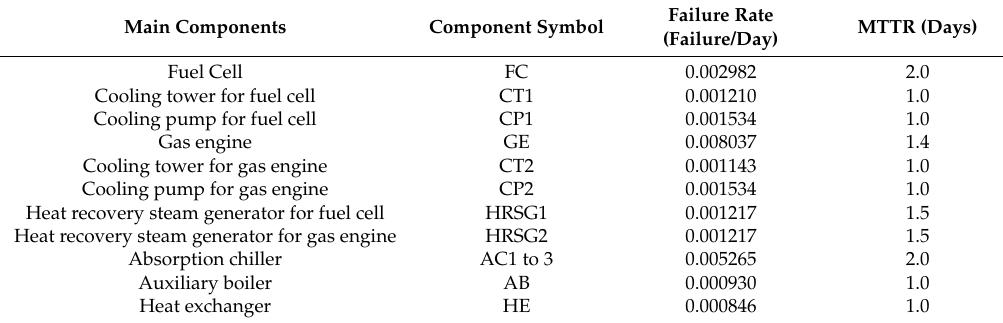
Table 11. The failure rate and MTTR of the main component of the CCHP system in